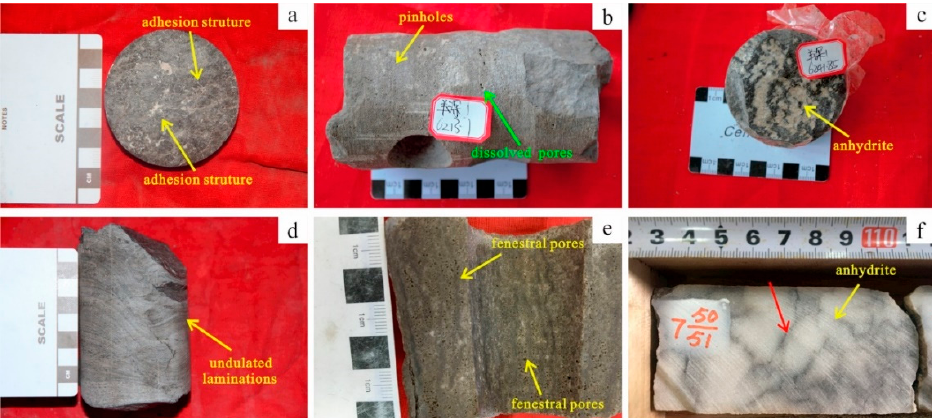
Figure 3. Macroscopic characteristics of the lithofacies types in the Leikoupo Formation. ( a ) Adhesion structure in thrombolites, T 2 l 43 , Pengzhou-103 well, 6045.20 m; ( b ) Pinholes (yellow arrow) and dissolved pores (green arrow) in thrombolites, T 2 l 43 , Yangshen-1 well, 6213.10 m; ( c ) Anhydrite filling in the original pores, T 2 l 42 , Yangshen-1 well, 6241.85 m; ( d ) Undulated laminations in stromatolites, T 2 l 43 , Longshen-1 well, 5990.26 m; ( e ) Fenestral pores in stromatolites, T 2 l 43 , Anfu-1 well, 5701.89 m; ( f ) Reticulated distribution of microbial dolomite in anhydrite (red arrow), T 2 l 42 , Anfu-1 well, 5716.71 m.